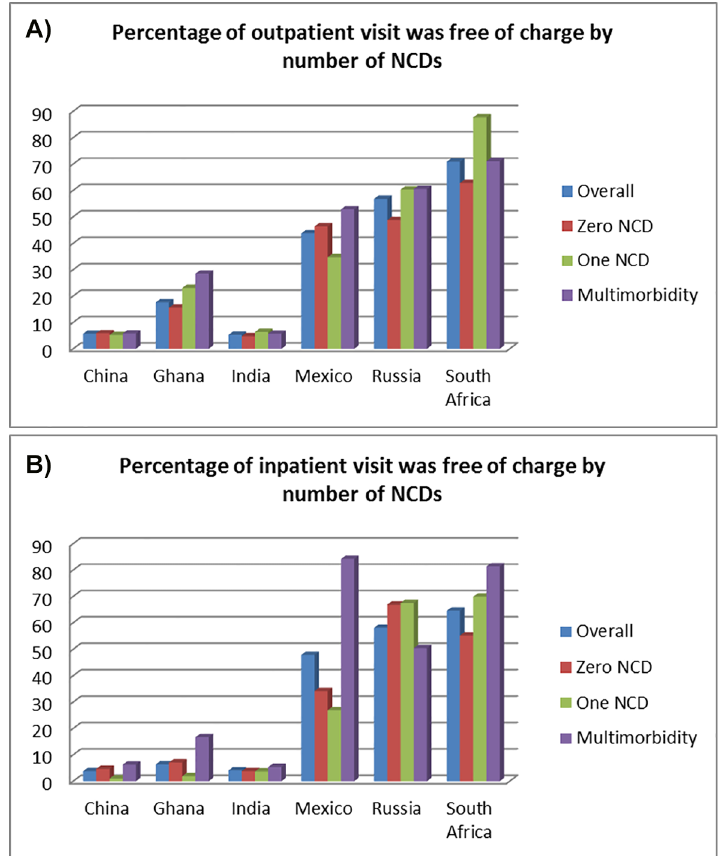
Fig 4. Proportion of respondents reporting that their last outpatient visit was free of charge (Fig 4a); Proportion of respondents reporting that their last inpatient visit was free of charge (Fig 4b). Data source World Health Organization (WHO) Study on Global Ageing and Adult Health (SAGE) survey, wave